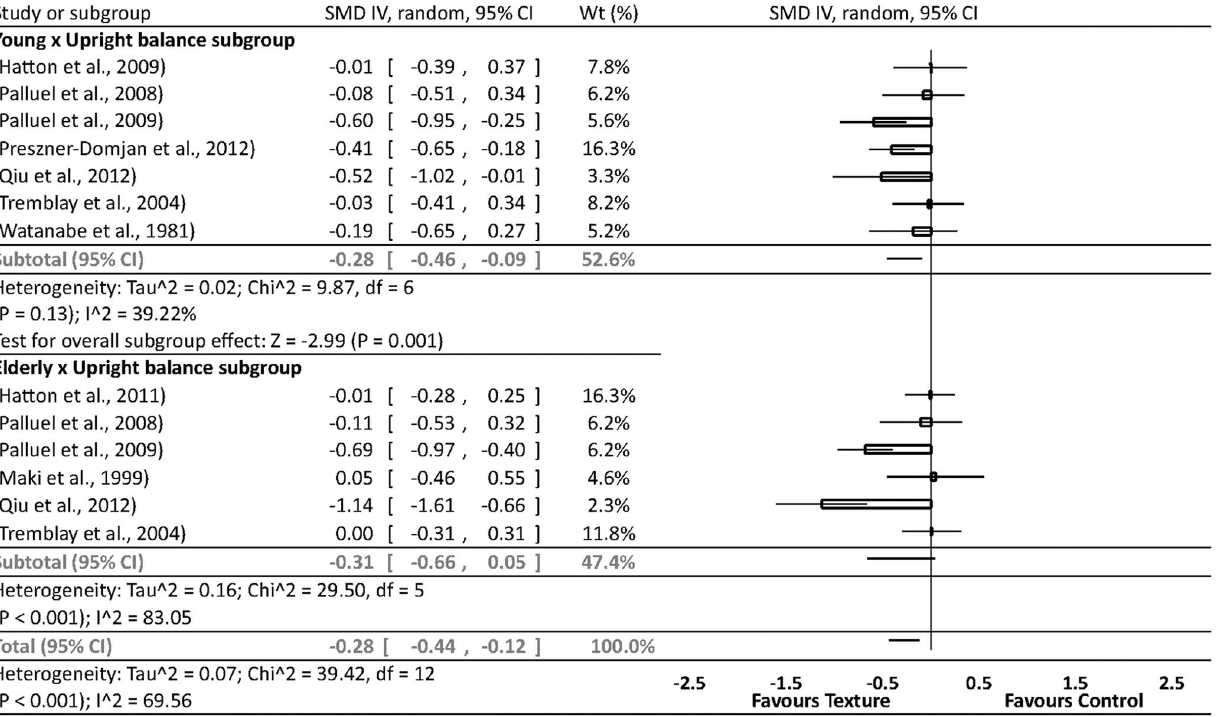
Figure 5. Forrest plot summary of textured material effects on perceptual-motor performance in upright balance tasks – age grouped. CI=confidence interval; IV=inverse variance; random=randomized; SMD=standardized mean difference; Wt=weight. Note: within groups vs baseline.